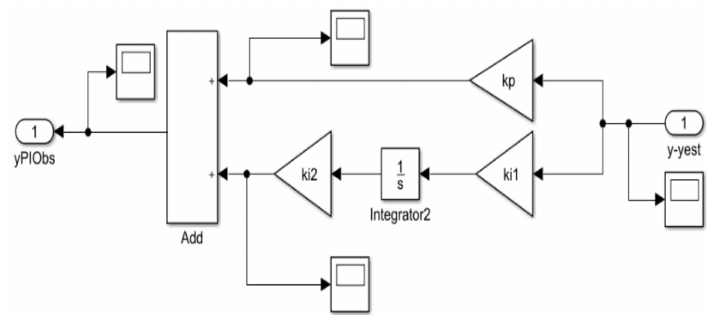
Figure 30. The Simulink model of PI